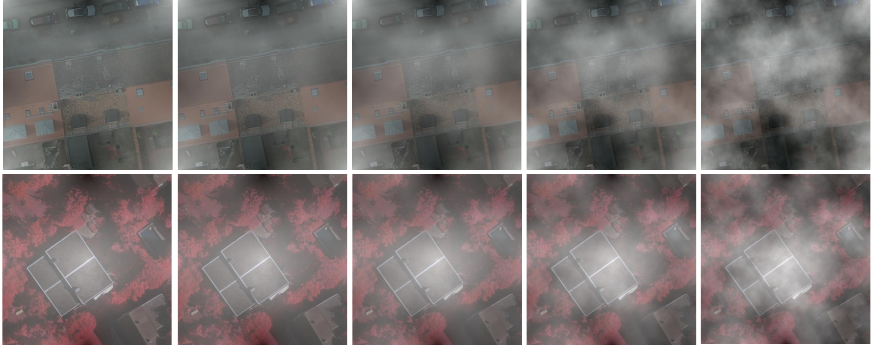
Figure 6. Illustrations of five severity levels of fog rendered the ISPRS dataset. First row: Potsdam. Second row: